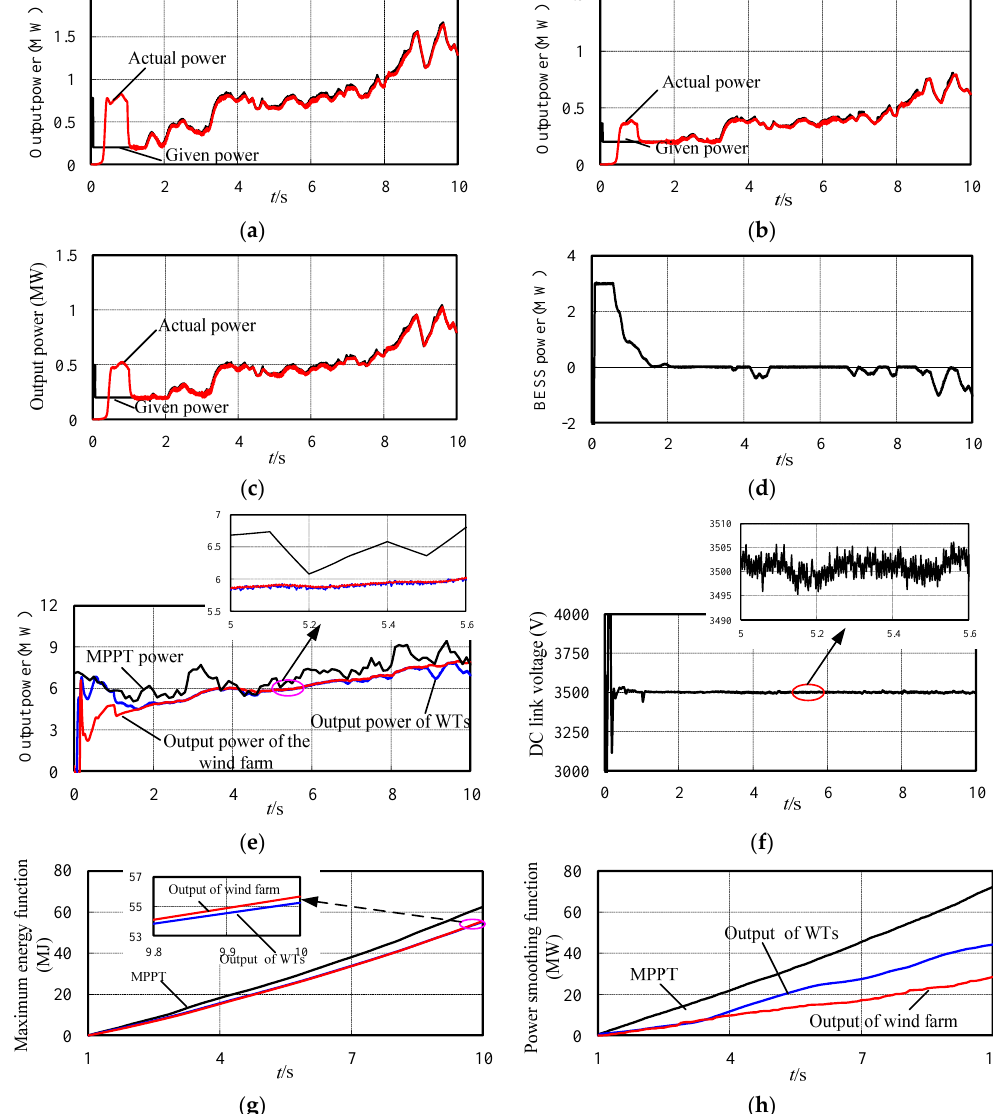
Figure 12. Time histories of the CWTs and the wind farm under the power smoothing operation mode. ( a ) Output power of CWT (WT7). ( b ) Output power of CWT (WT8). ( c ) Output power of CWT (WT9). ( d ) Power of the BESS. ( e ) Total output power of the wind farm. ( f ) DC link voltage. ( g ) Maximum energy function. ( h ) Power smoothing function.